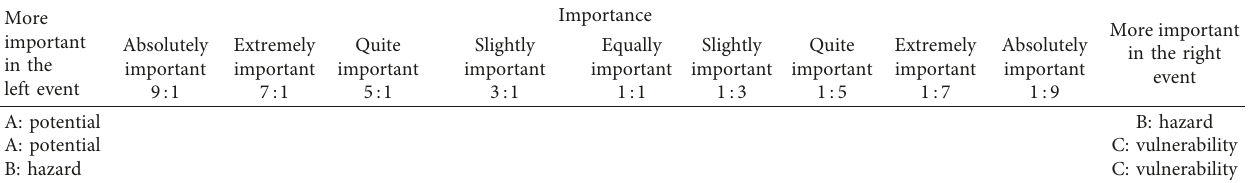
Table 4: Questionnaire example of pair comparison in the AHP.